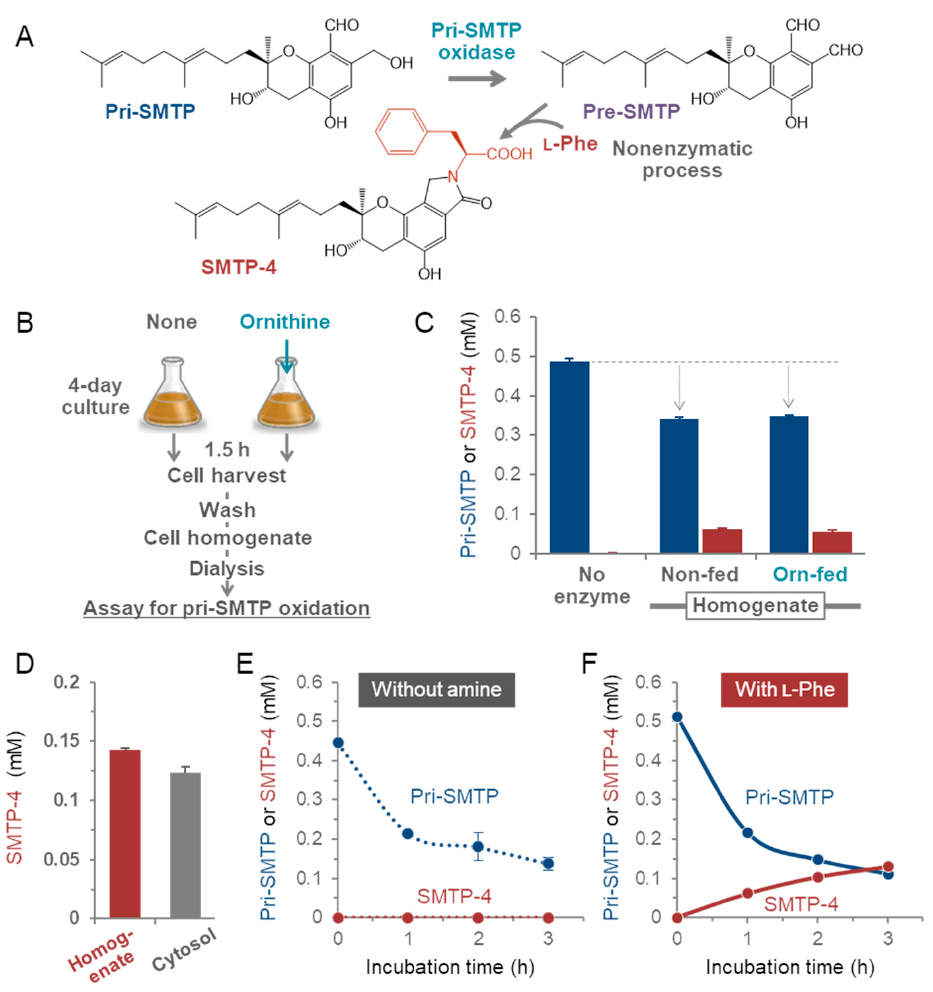
Figure 4. Detection of pri-SMTP oxidation in a cell-free assay. ( A ) The scheme for the cell-free assay system. The oxidation of pri-SMTP affords pre-SMTP, which is difficult to be detected in enzyme assays, since it may form adducts by reacting with amino groups in proteins present in the enzyme preparations. The inclusion of L-phenylalanine in the system facilitates the formation of SMTP-4, a product of the reaction between pre-SMTP and L-phenylalanine, thus enabling the assay for pri-SMTP oxidation by measuring the decrease in pri-SMTP and the concomitant formation of SMTP-4. ( B ) Preparation of cell homogenates. On Day 4 of the culture of S. microspora , L-ornithine or none was added, and culture was continued for another 1.5 h. Subsequently, cells were harvested, washed, and disrupted to prepare cell homogenates, which was then dialyzed to remove small-molecule amine compounds. An assay for pri-SMTP oxidation was performed using the dialysate. ( C ) Pri-SMTP oxidation proceeds depending on the cell homogenates. The oxidation occurs equally, whether cells have been treated or not treated with L-ornithine, demonstrating that the pri-SMTP oxidation activity is constitutively expressed, and is not induced by amine treatment. ( D ) Nearly all of the pri-SMTP oxidation activity exists in the cytosolic fraction. ( E , F ) Pri-SMTP oxidation proceeds without amine in the assay system, and SMTP is formed when an amine is included in the system. Each value represents the mean + SD (error bar) from triplicate